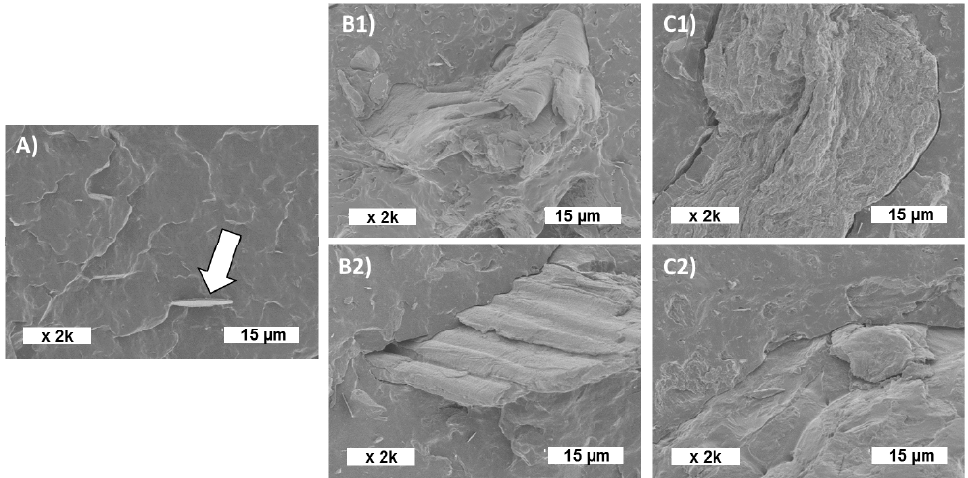
Figure 4. SEM observation of the cross section of composites: ( A ) neat PHBV (white arrow shows boron nitride), ( B1 ) 20ViSh-V, ( B2 ) 20ViSh-E, ( C1 ) 20WiPo-V and ( C2 )